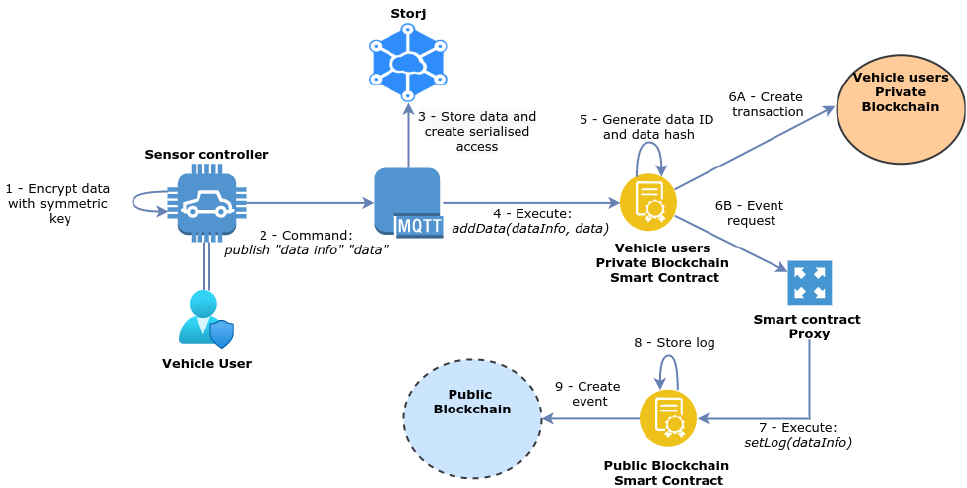
Figure 5. Data published by a sensor controller to be stored in Storj and in the blockchain.